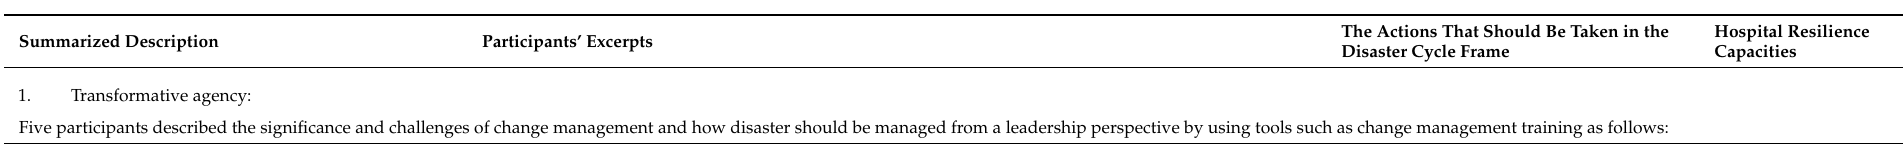
Table 2. Governance and